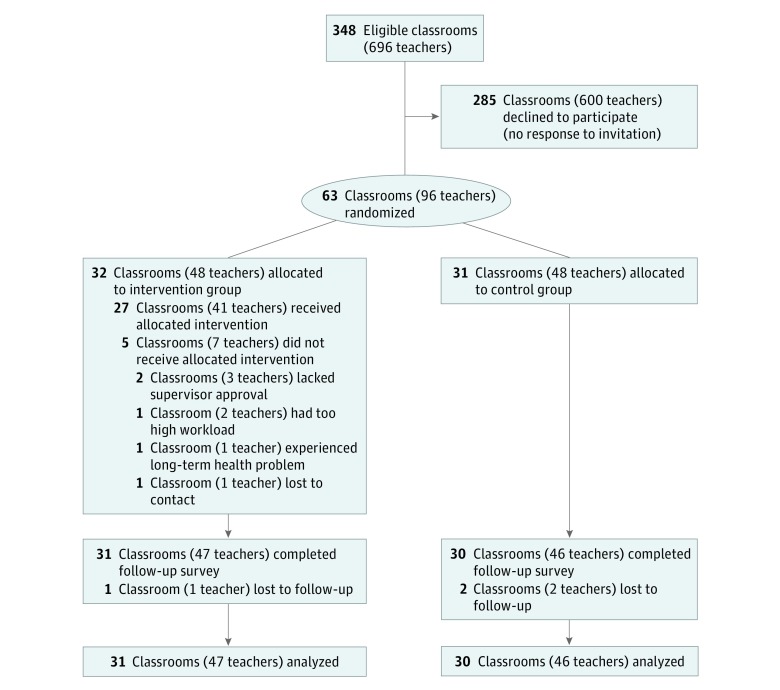
CONSORT Flowchart Describing Progress of Participants Through the Study